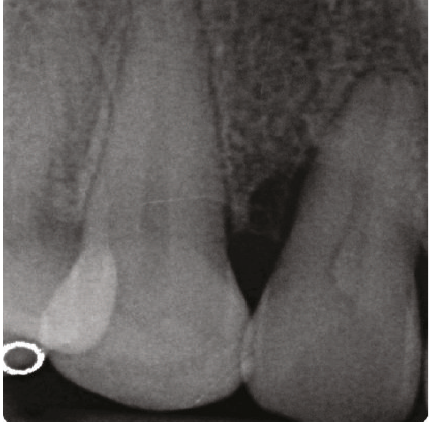
Figure 12: Radiographic examination: no bone resorption is visible in correspondence of the involved tooth.